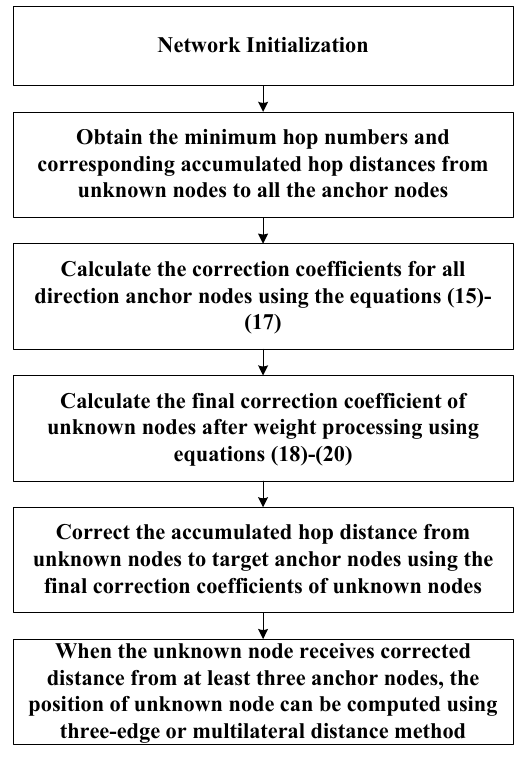
Figure 4. Simulation flow chart of the proposed algorithm.